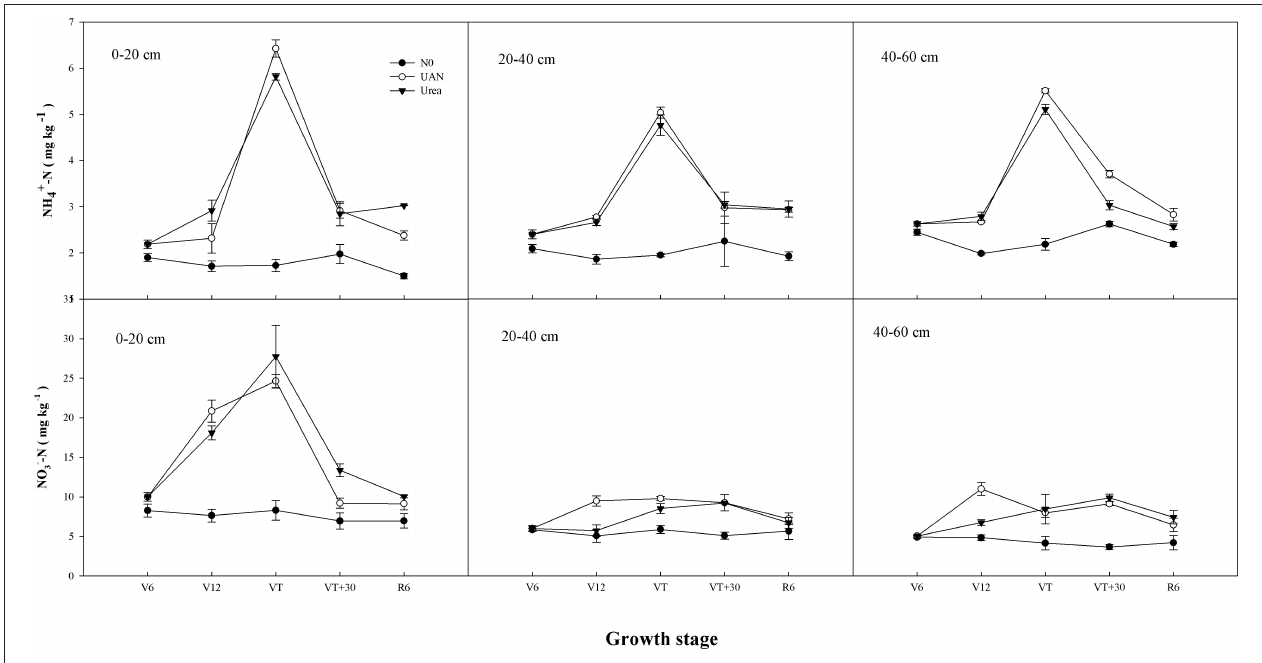
FIGURE 3 | Effects of nitrogen fertilizer types on soil NO − 3 -N and NH + 4 -N